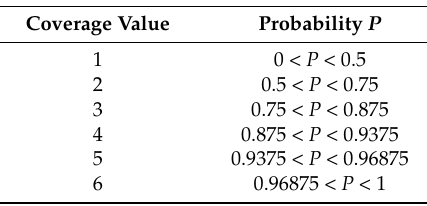
Table 1. Probability P of a successful communication between the BN and a SN within the same subnetwork and its corresponding coverage value.